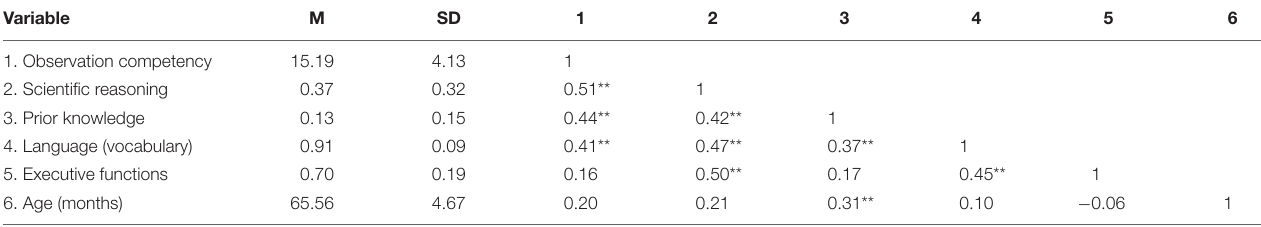
TABLE 7 | Means, standard deviations, and intercorrelations for observation competency and all predictor variables. Variable M SD